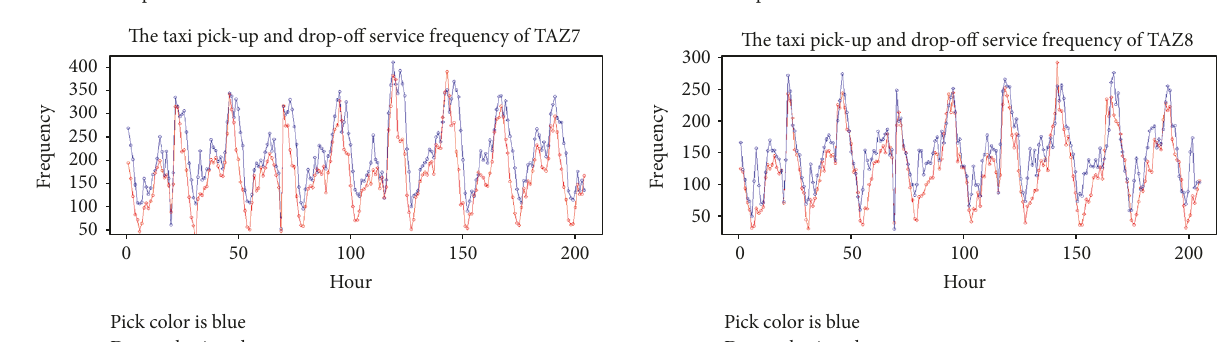
redPick color is blue Drop color is red